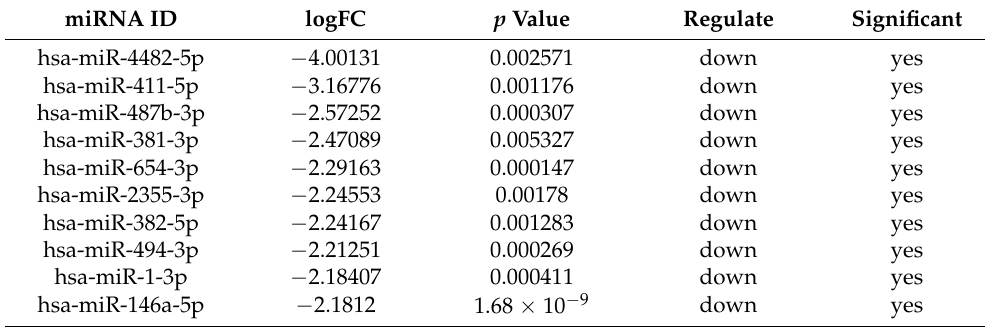
Table 4. The top 10 down-regulated miRNAs in leishmaniasis patients compared to healthy control group. miRNA ID logFC p Value Regulate Significant hsa-miR-4482-5p − 4.00131